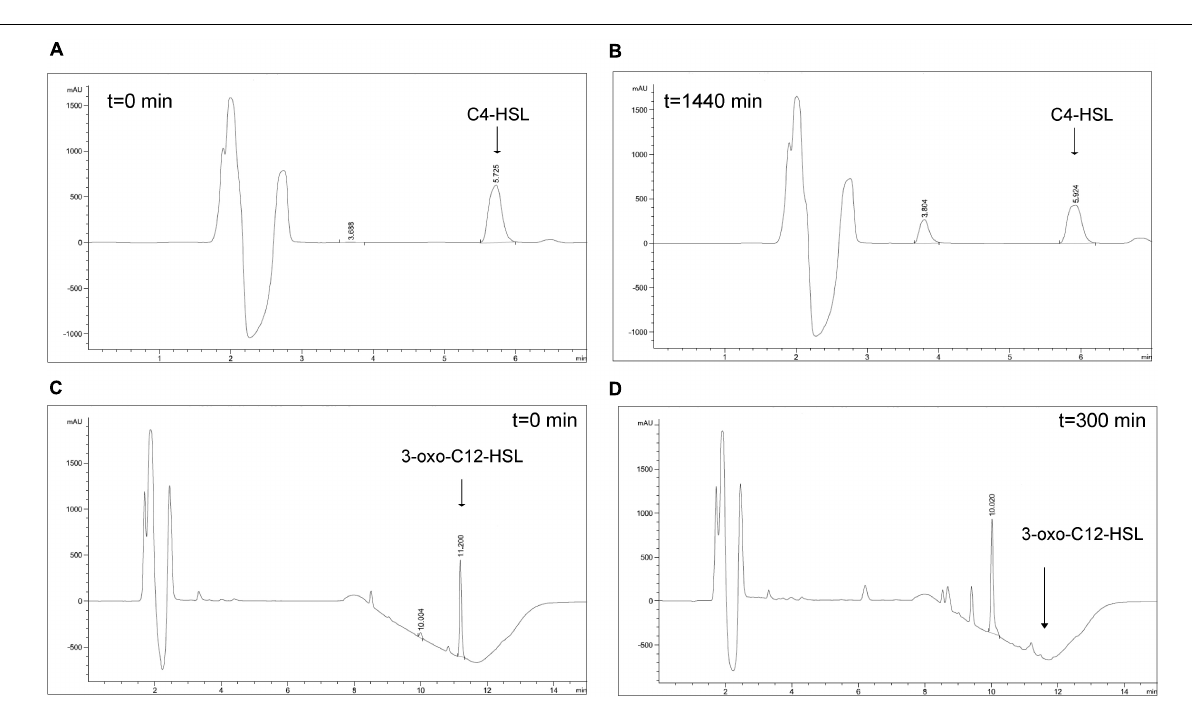
Frontiers in Microbiology |